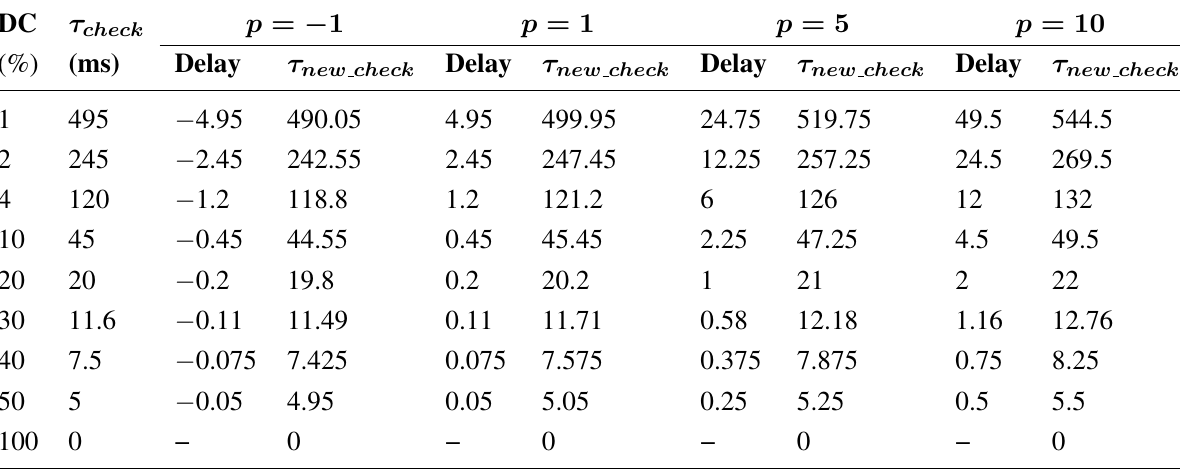
Table 1. Configuration of delays for different values of DC and p . The values of delays and (cid:28) are all expressed in new check